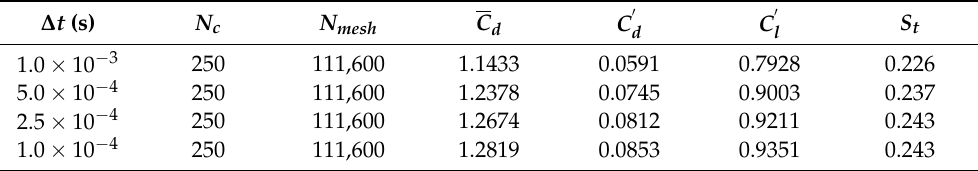
Table 2. Comparisons of the global parameters for the time step independence study.